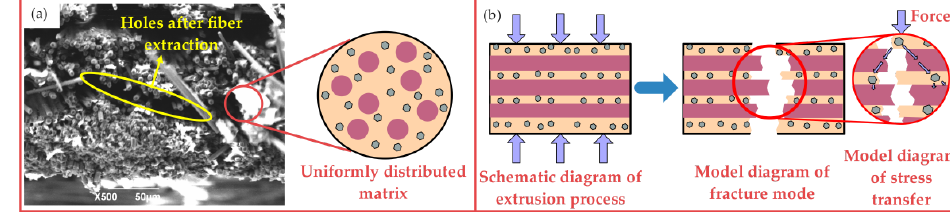
Figure 10. Fracture microstructure and mechanism of GO-CF/EP composite (50 °C): ( a ) fracture microstructure, ( b ) fracture mechanism.